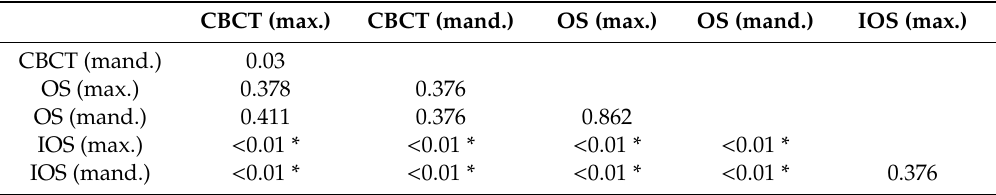
Table 3. The statistical outcome of a precision comparison between different scanners with respect to maxillary/mandibular dental cast models.